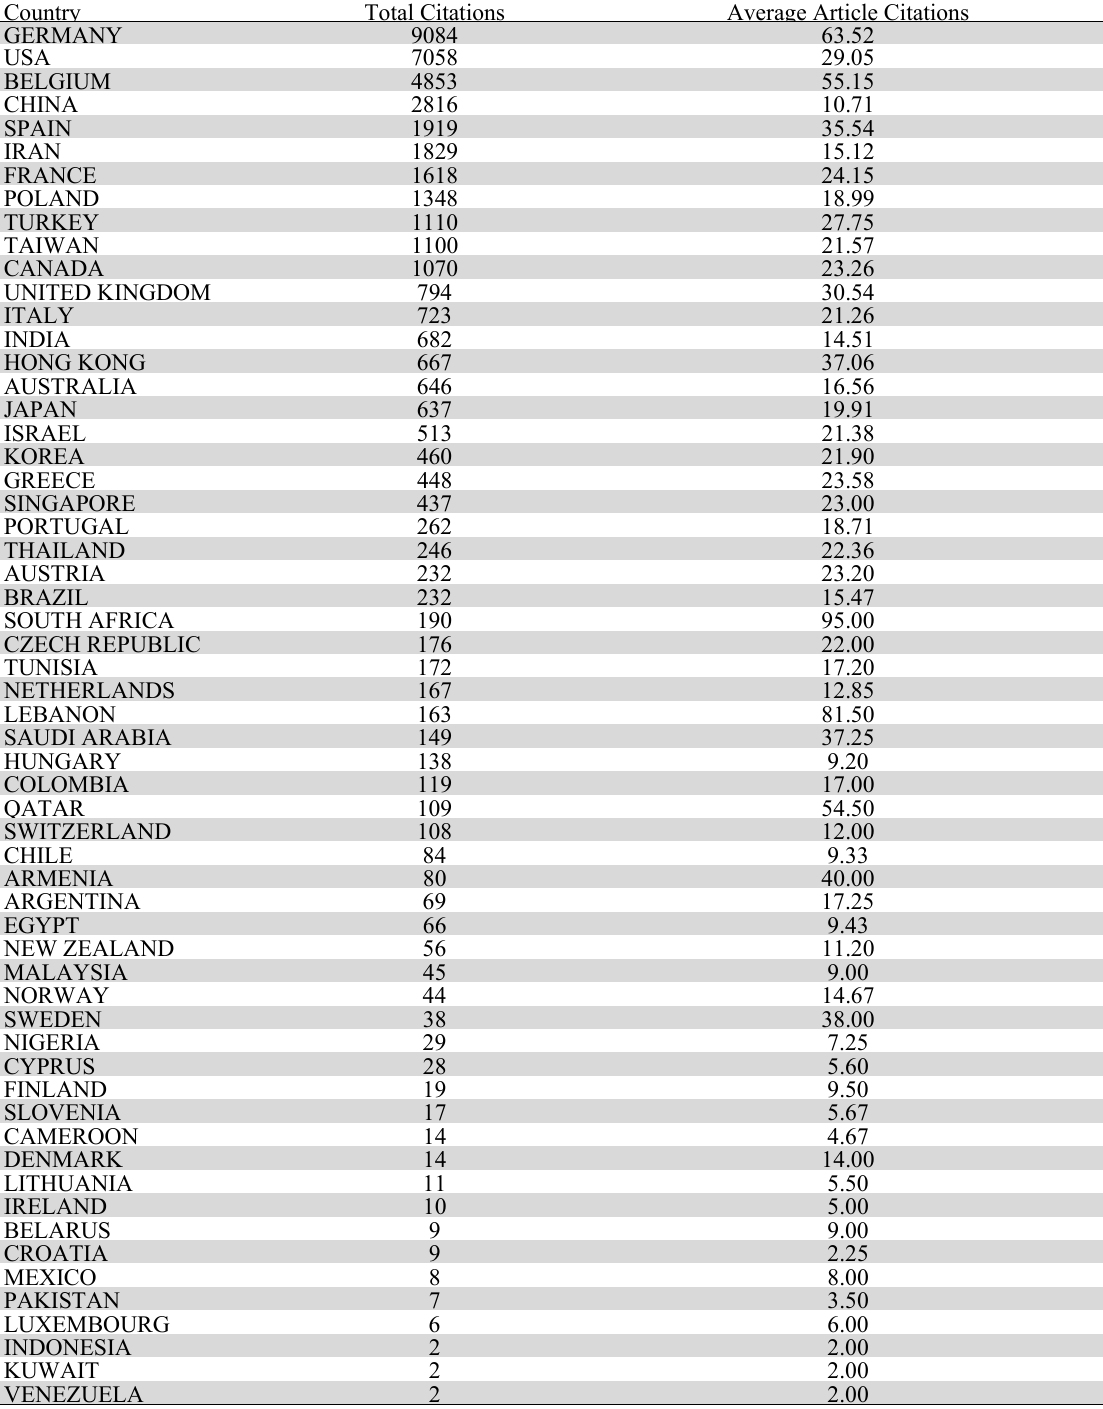
The summary of the contributions of different countries